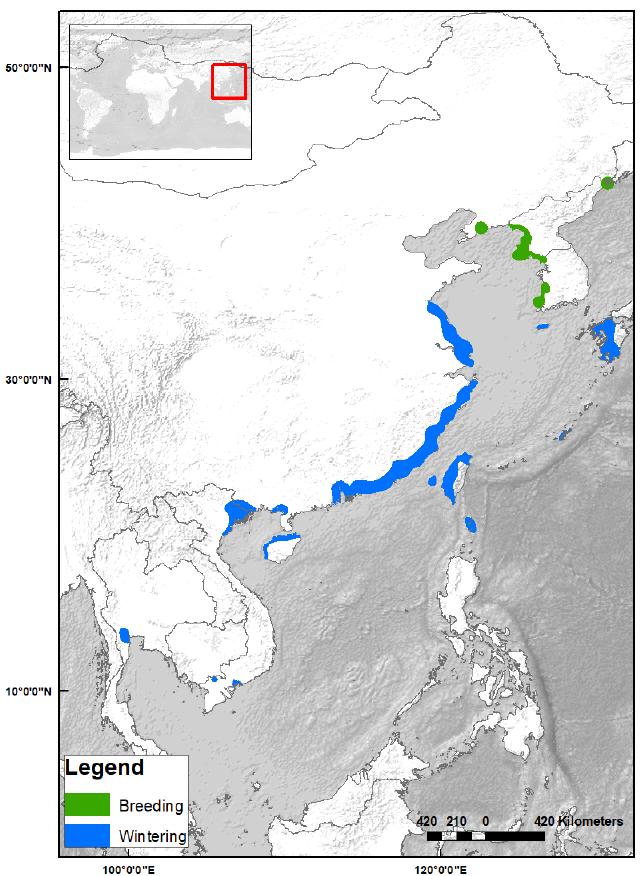
Figure 1. Map showing current breeding areas and regular wintering areas based on BirdLife International [5] and Chen et al. [6].